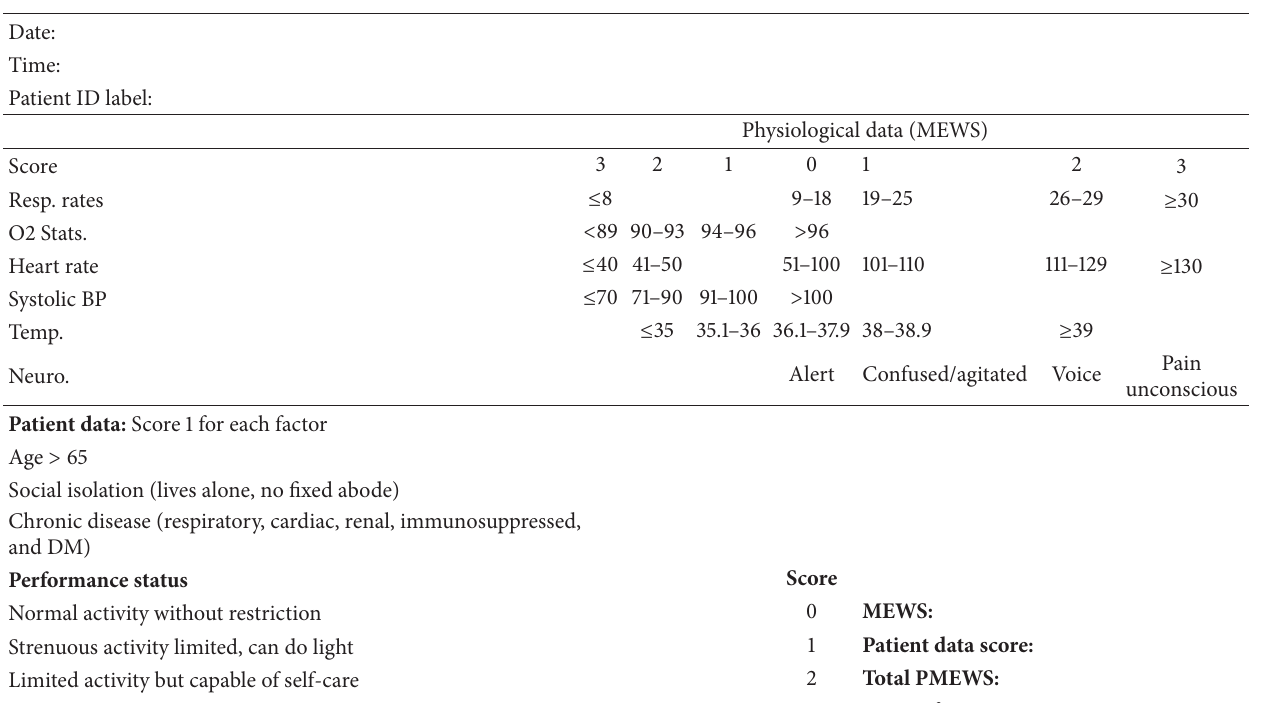
Table 1: PMEWS admission